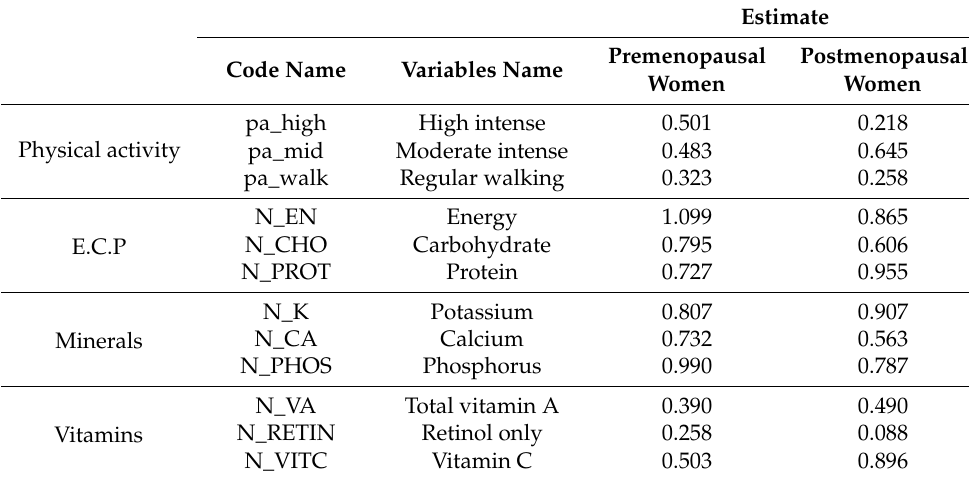
Table 4. Standard regression weights of independent